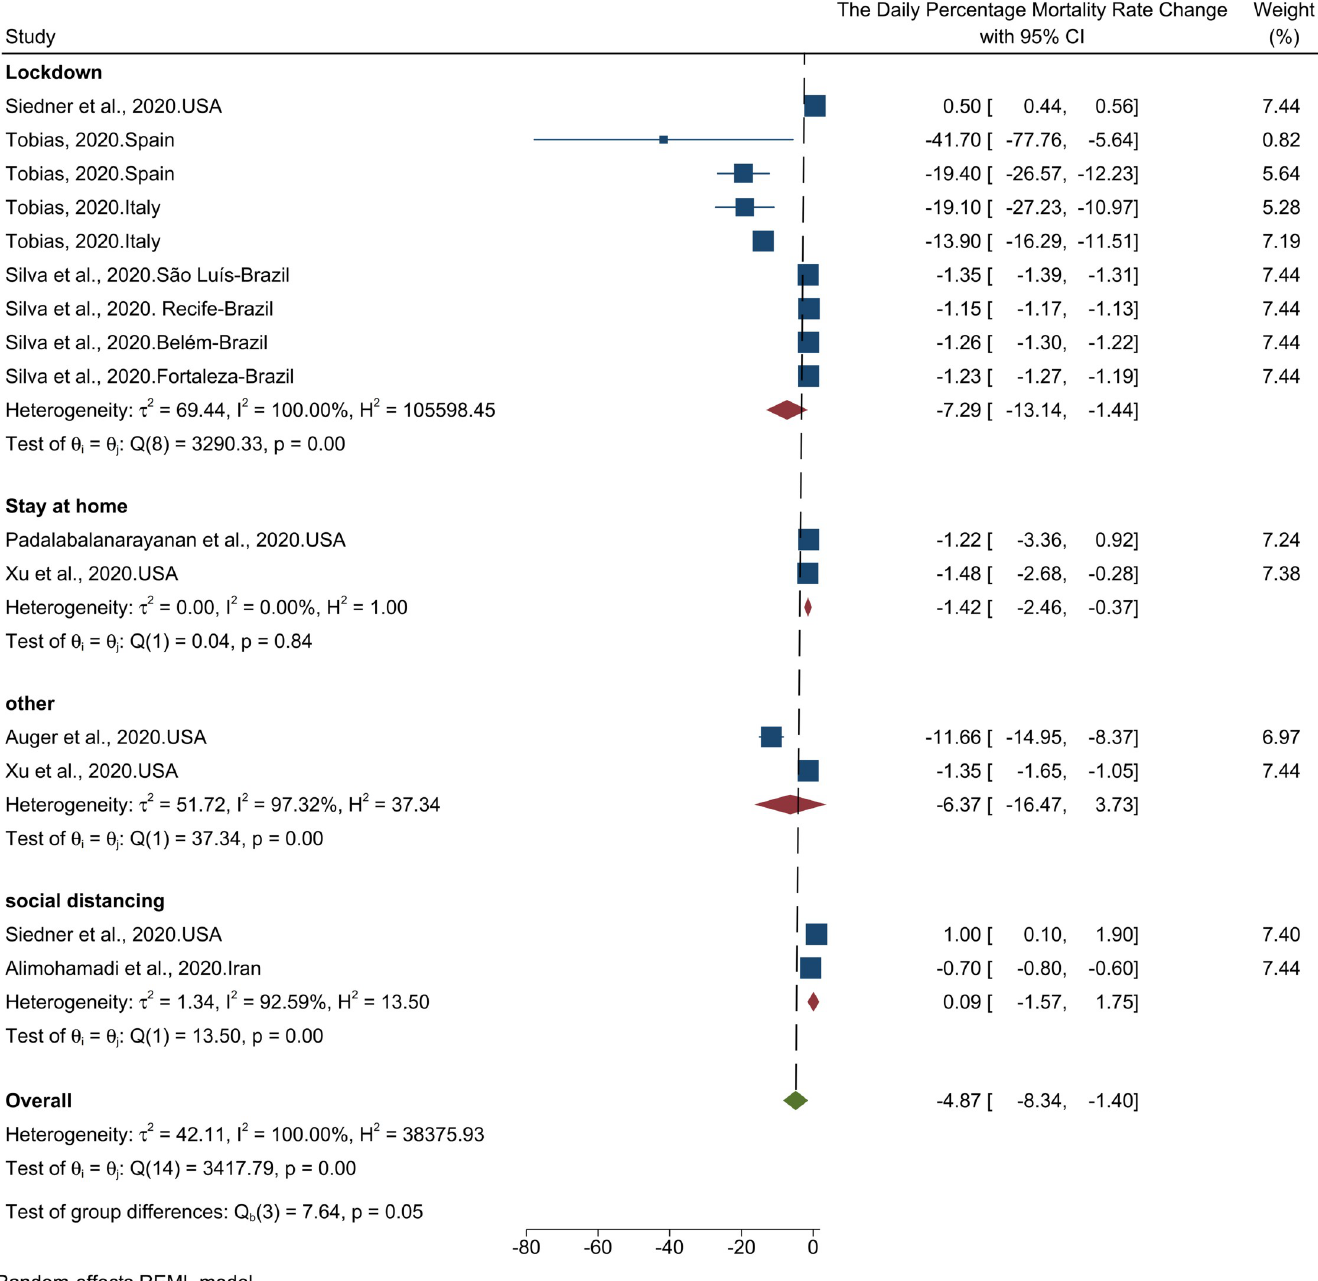
PLOS ONE | https://doi.org/10.1371/journal.pone.0260371 November23,